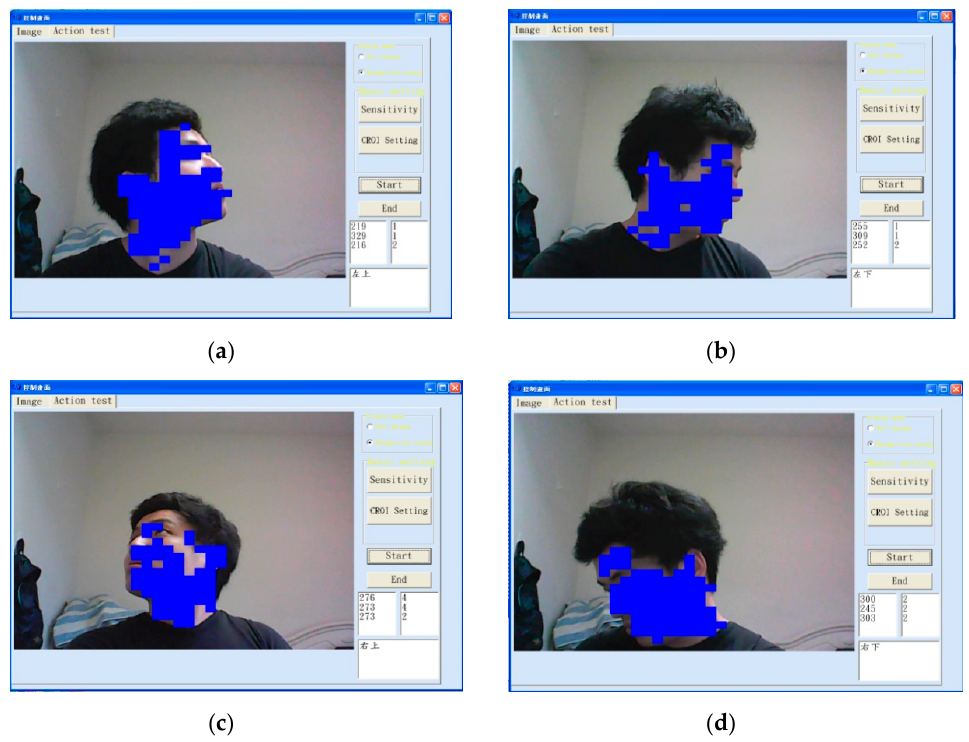
Figure 4. Test conditions of the ( a ) left ‐ upward, ( b ) left ‐ downward, ( c ) right ‐ upward, and ( d ) right ‐ downward movements of the head.